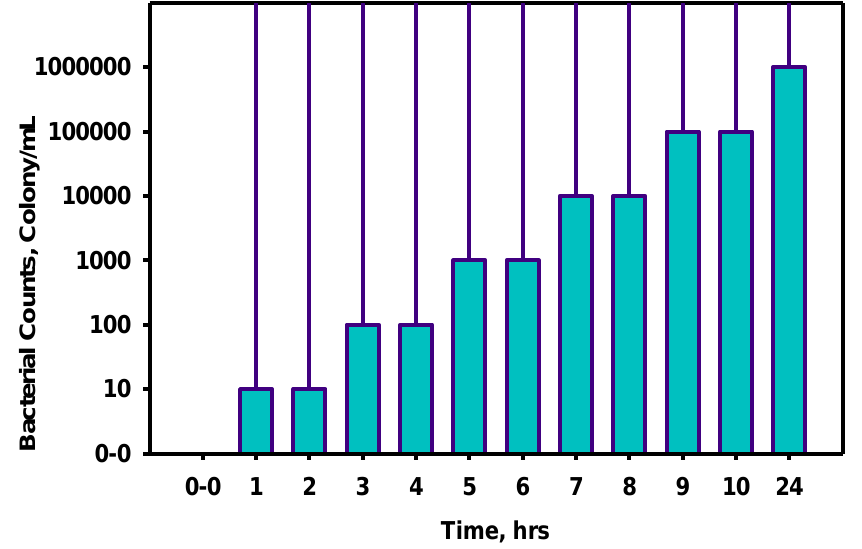
Figure 1. The counts of aerobic bacteria in the absence of ionic liquids.